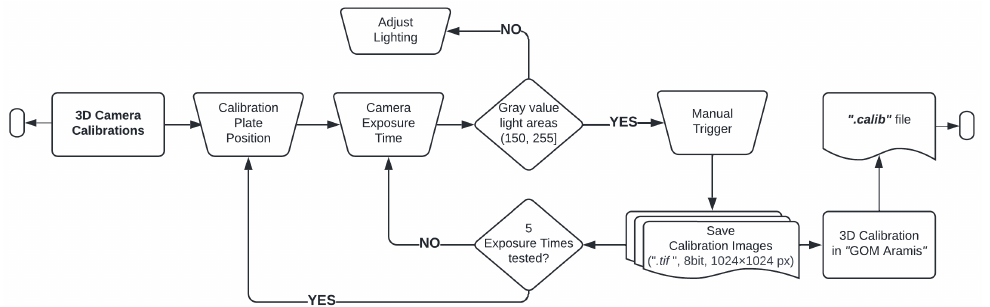
Figure 3. Camera calibration process for determining 3D coordinates in static event